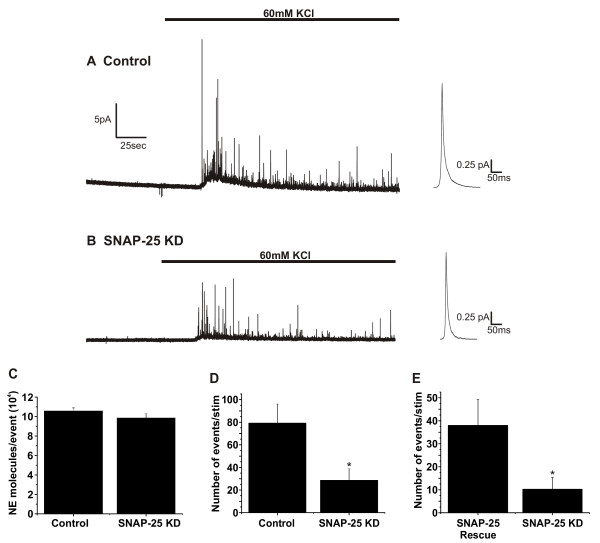
Catecholamine secretion is reduced in SNAP-25 knockdown PC12 cells. Representative amperometric traces are shown from a control cell stably transfected with pG418-shRNA lacking an shRNA insert (empty vector) (A) and from a SNAP-25 knockdown cell prior to and during a 2.5 min stimulation with 60 mM KCl (B). To the right of each of the traces is an averaged amperometric event shown on an expanded time scale. C) When compared to empty vector controls (n = 18) the silencing of SNAP-25 in PC12 cells (n = 18) did not alter the number of norepinephrine molecules per release event. D) Silencing of SNAP-25 resulted in a 63% reduction in the total number of exocytotic events produced following stimulation. Control transfected cells and SNAP-25 knockdown cells produced a mean ± SEM of 79 ± 17 events and 29 ± 10 events, respectively. *p < 0.03 (Student's t-test). E) Transient transfection with a human SNAP-25 expression plasmid rescued the deficit in catecholamine secretion in the SNAP-25 knockdown cells. *p < 0.03 (Student's t-test).